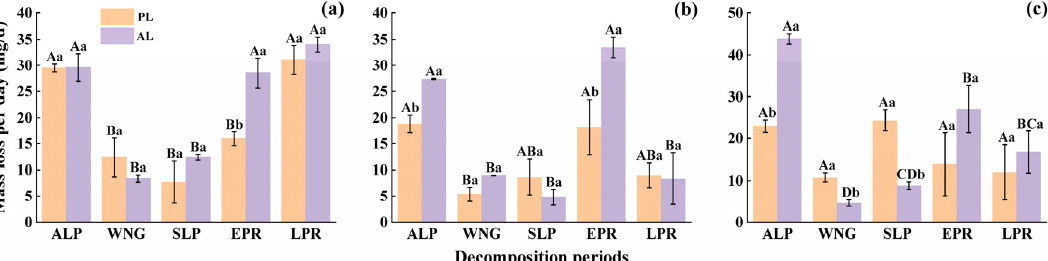
Figure 2. The accumulative mass loss rates (%) of goldenrain tree ( a ), camphor tree ( b ), and weeping willow tree ( c ) foliar litter in the urban forest. PL and AL indicate physiological and abnormal litter,